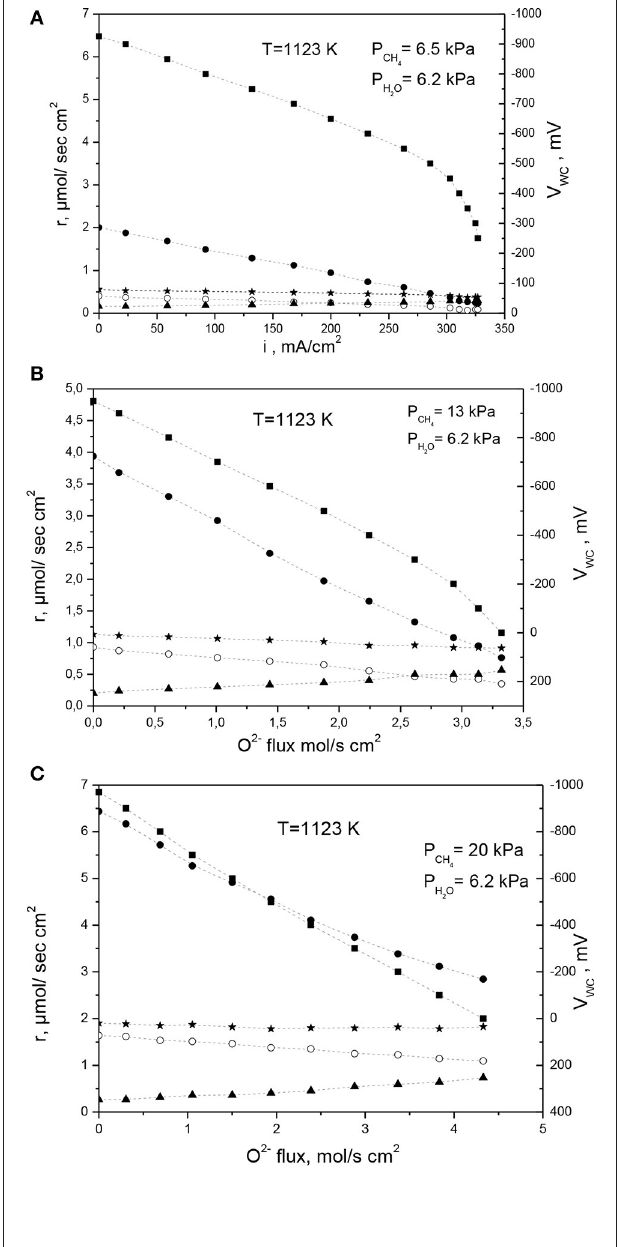
FIGURE 10 | Electrokinetic measurements on Ni-Au(1 at%)/YSZ under internal steam reforming conditions at T = 1,123K and S/C ratios (A) 0.95, (B) 0.47, , r H , ◦ r CO , r CO2 ) The total flow rate was 83–107 (C) 0.31. ( V WC , r CH 2 4 cc/min, while the methane flow was adjusted between 5 and 20 cc/min, depending on the methane partial pressure that was fed to the anode. Reprinted with permission from Gavrielatos et al. (2008).